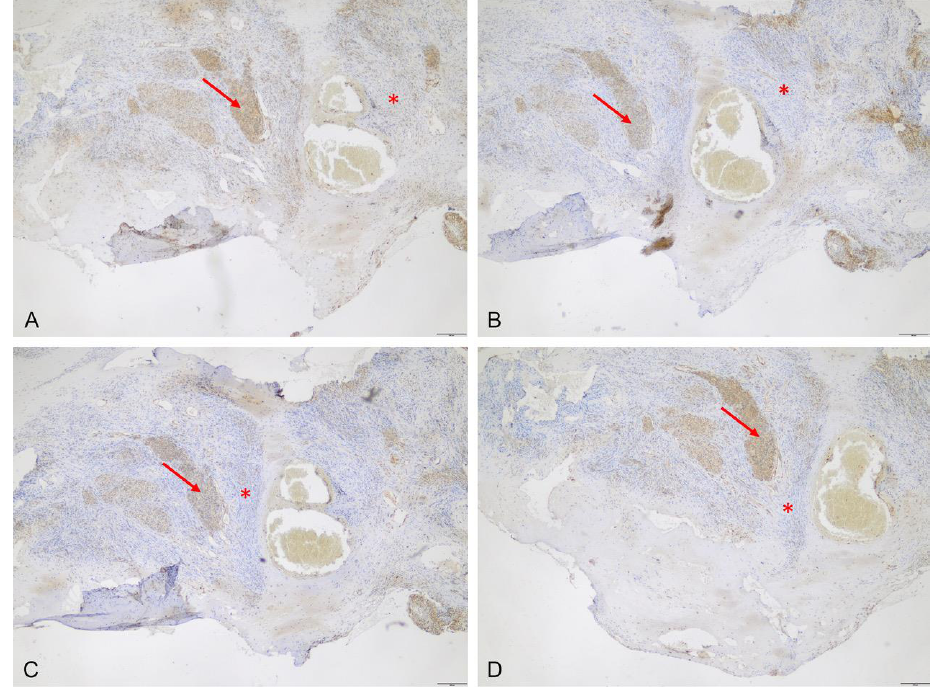
Figure 3. Protein expression of ABCB6, ABCG2, FECH and CPOX in fluorescent non-neoplastic CNS tissue. Both diffuse ABCB6 ( A ) and nuclear CPOX ( D ) as well as weak nuclear FECH ( C ) and patchy ABCG2 ( B ) protein staining could be detected. The arrow in ( B ) indicates endothelial ABCG2 staining (scale bar 100 µm, magnification 10-fold).